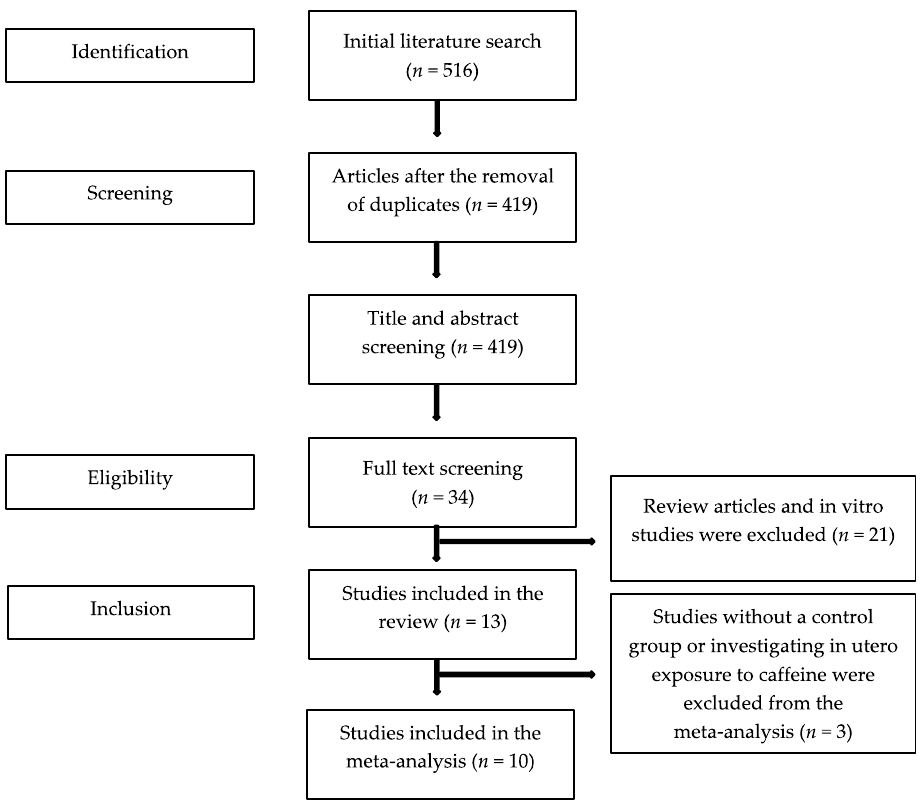
Figure 1. Flowchart of the literature search process.